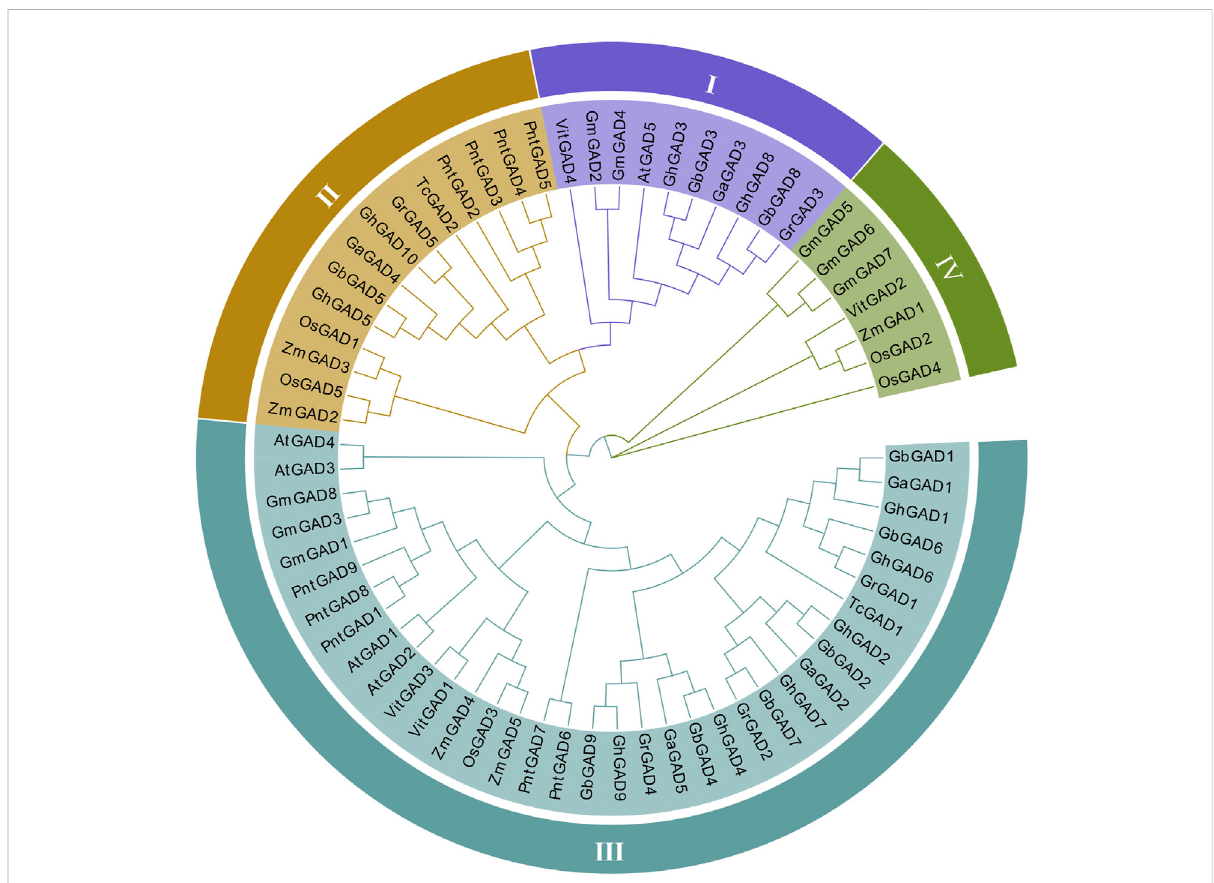
FIGURE 1 Phylogeny tree constructed using MEGA7 by the Neighbor-Joining (NJ) method. Phylogenetic relationship of the 67 identi fi ed GAD s from G. hirsutum , G. barbadense , G. arboreum , G. raimondii , A. thaliana , V. vinifera , P. trichocarpa , T. cacao , G. max , O. sativa, and Z. mays . The tree shows 4 major phylogenetic